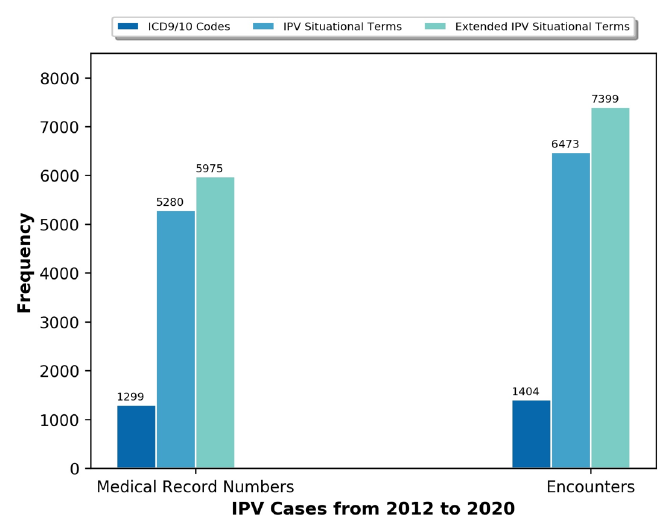
Figure 2. Identified intimate partner violence (IPV) cases using ICD-9/10 codes, IPV situational terms and extended IPV situational